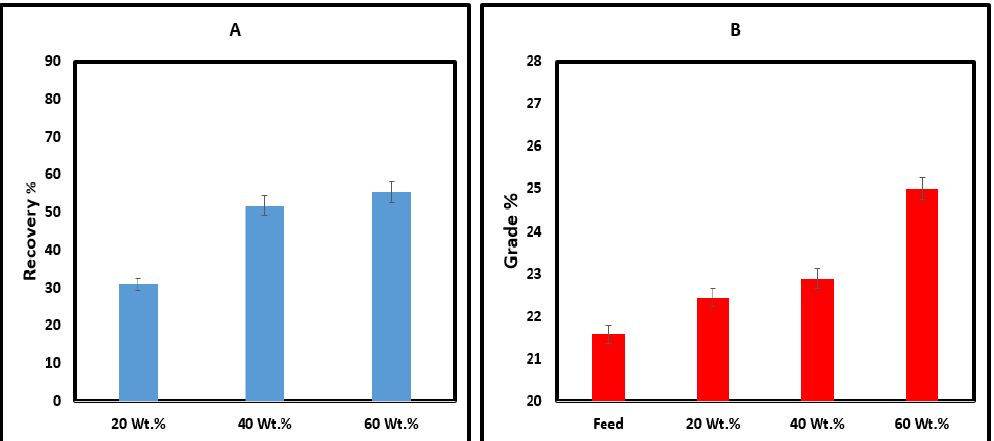
Figure 11. ( A ) Flotation recovery and ( B ) P 2 O 5 grade (%) at different percentages of pulp solids (wt %) in the presence of sodium silicate dispersant.